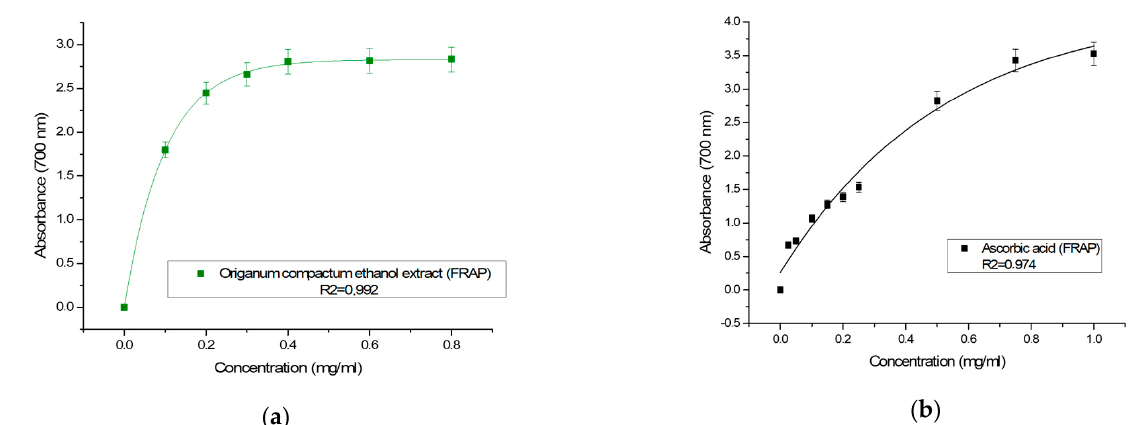
Figure 2. ( a ) Antioxidant activity of hydroethanolic extract of Origanum compactum by FRAP; ( b ) antioxidant activity of ascorbic acid by FRAP.